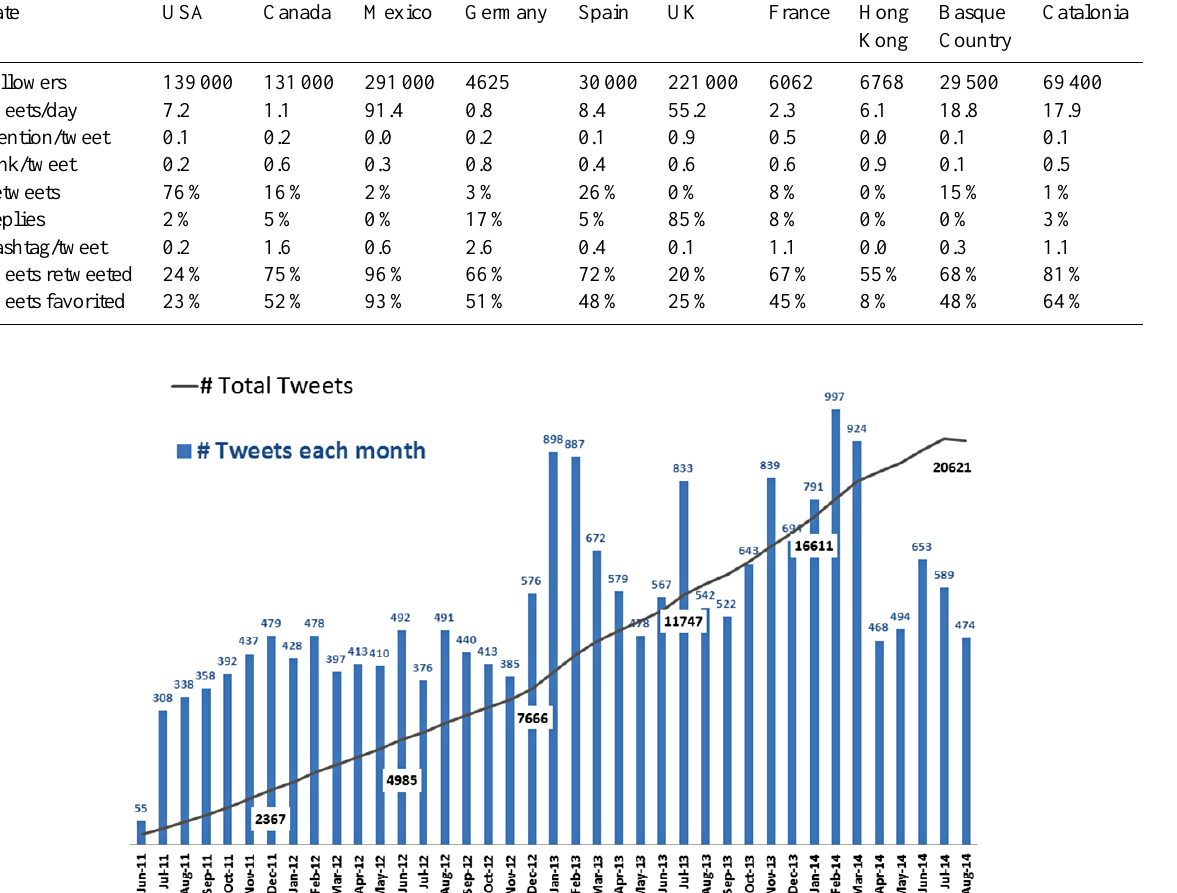
Figure 5. Evolution of tweets posted by